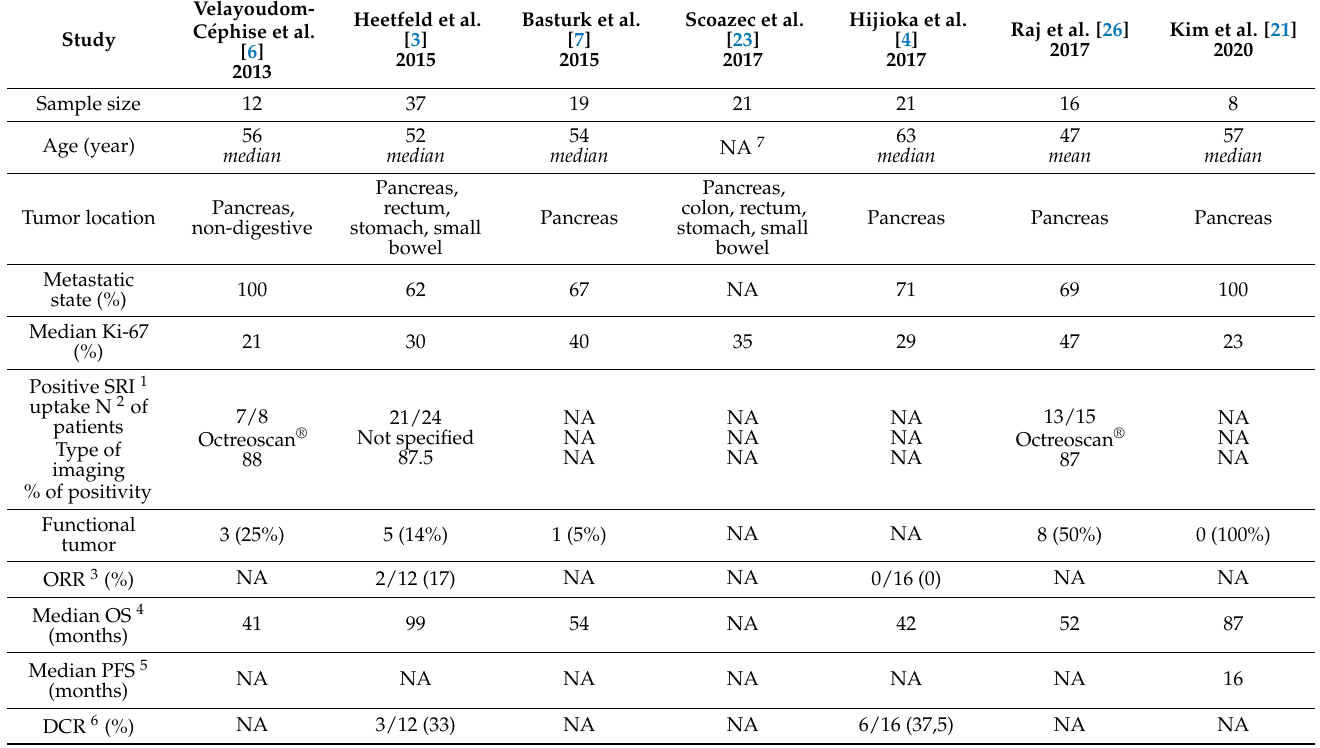
Table 2. Results from main studies evaluating grade 3 neuroendocrine tumors (NET G-3) patients.